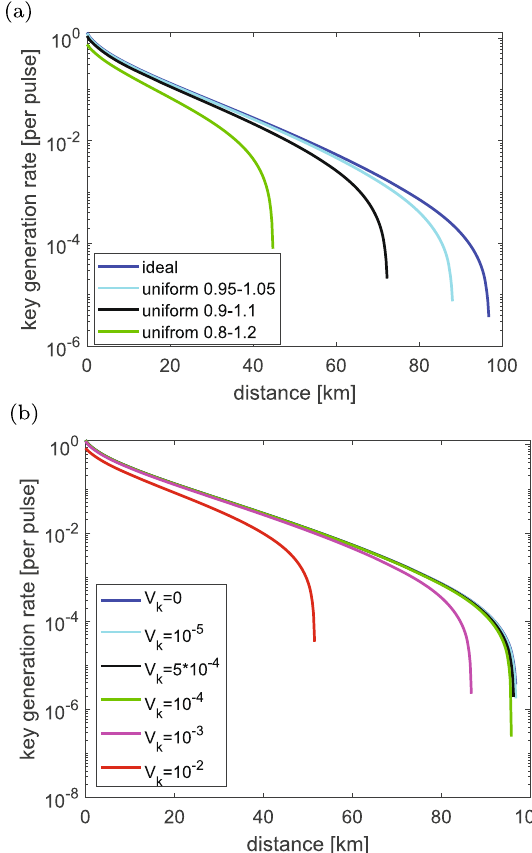
Fig. 4 The secret key rate of case (2A). ( a ) Uniform distribution ( b ) Gaussian distribution. Here, we compute the secret key rates R 2 A with two intensity fl uctuation models. a The secret key rates versus transmission distance for different intensity fl uctuation models of